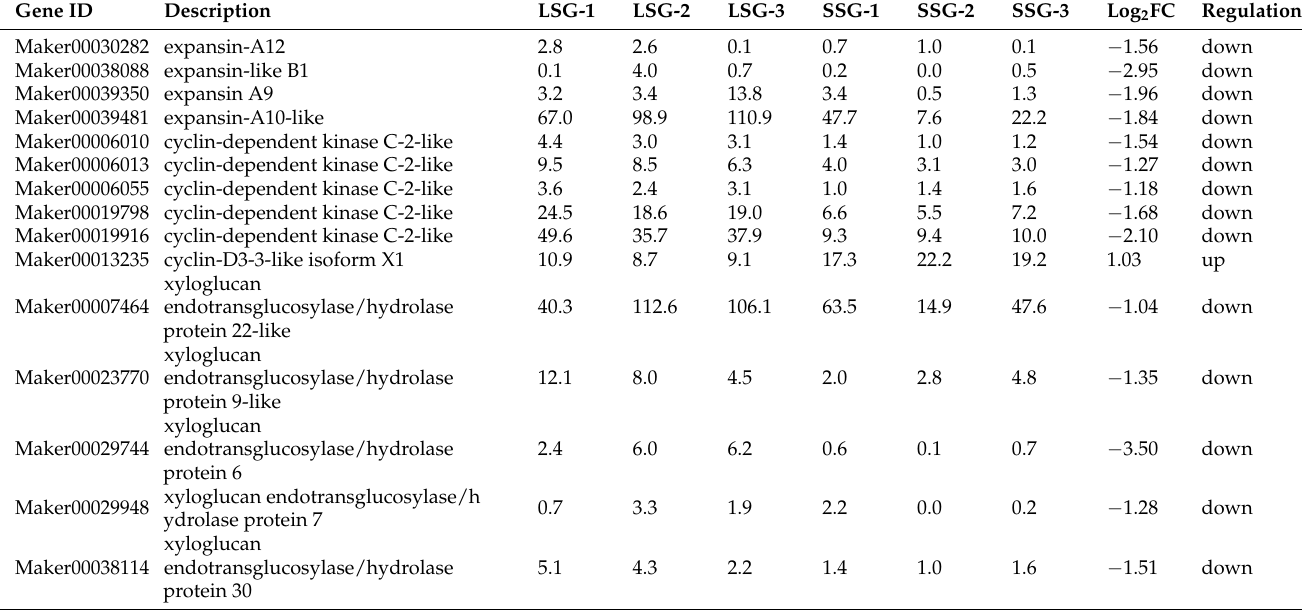
Table 3. Differentially expressed genes associated with the cell cycle and cell